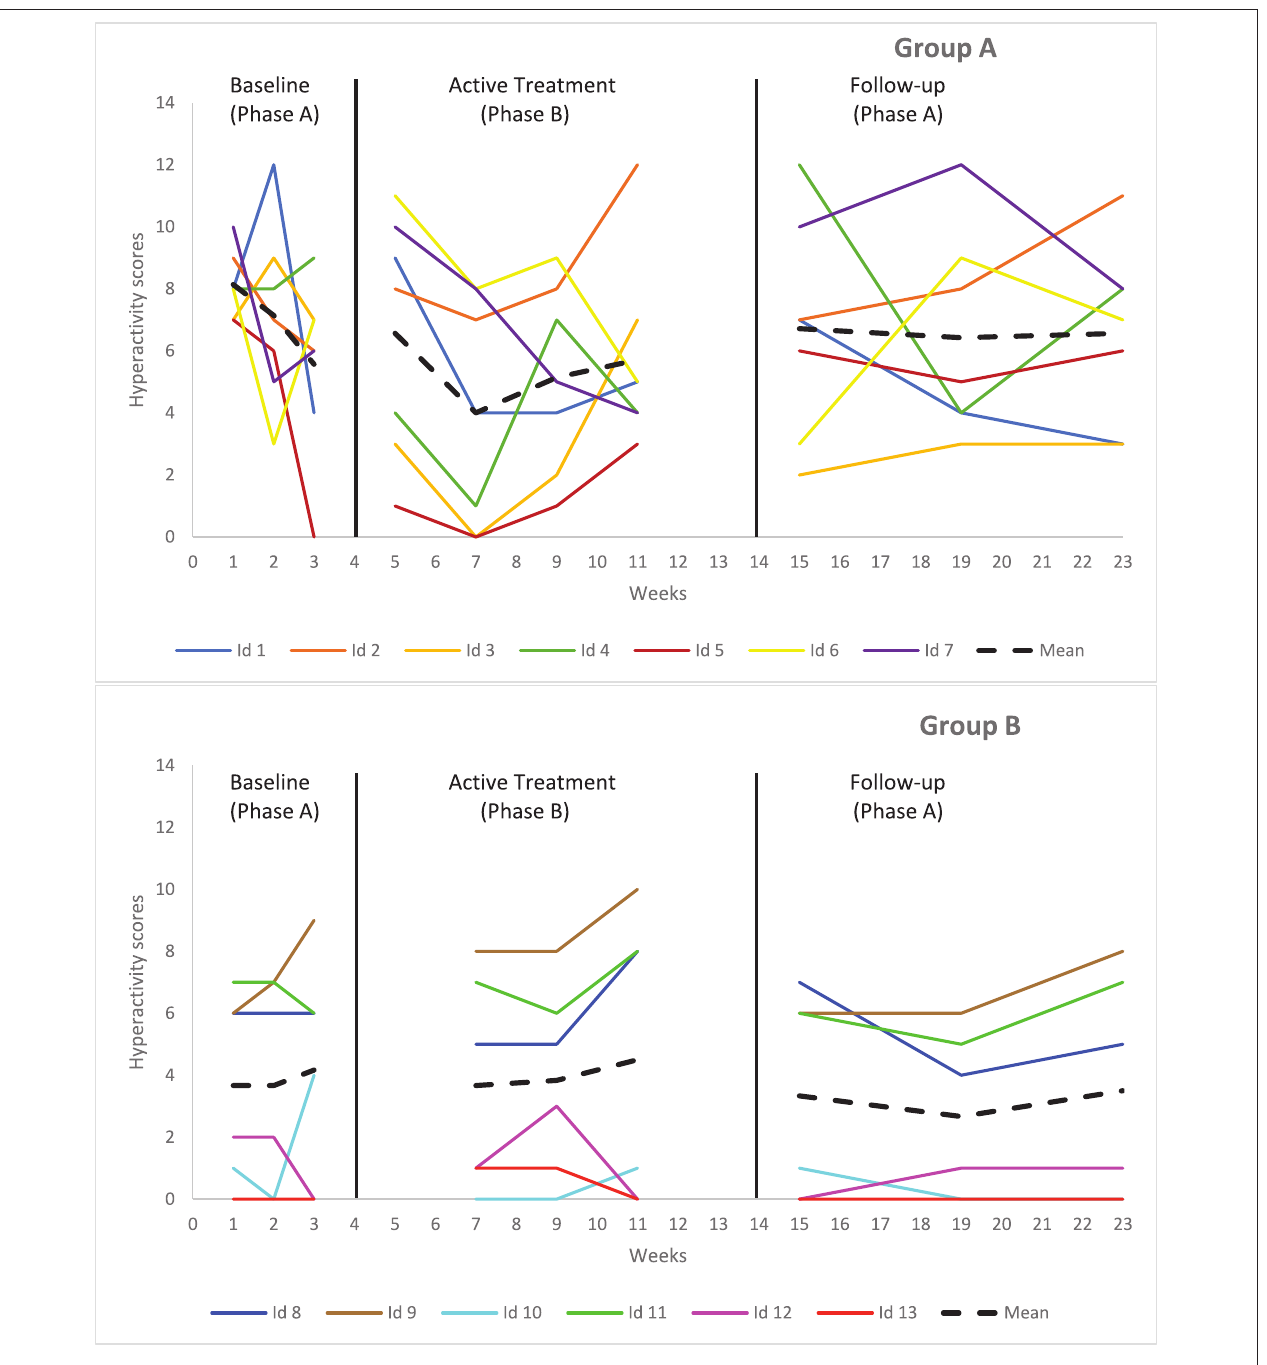
FIGURE 9 | Graphical display of baseline level and changes in level between consecutive phases in hyperactivity for teacher-reported